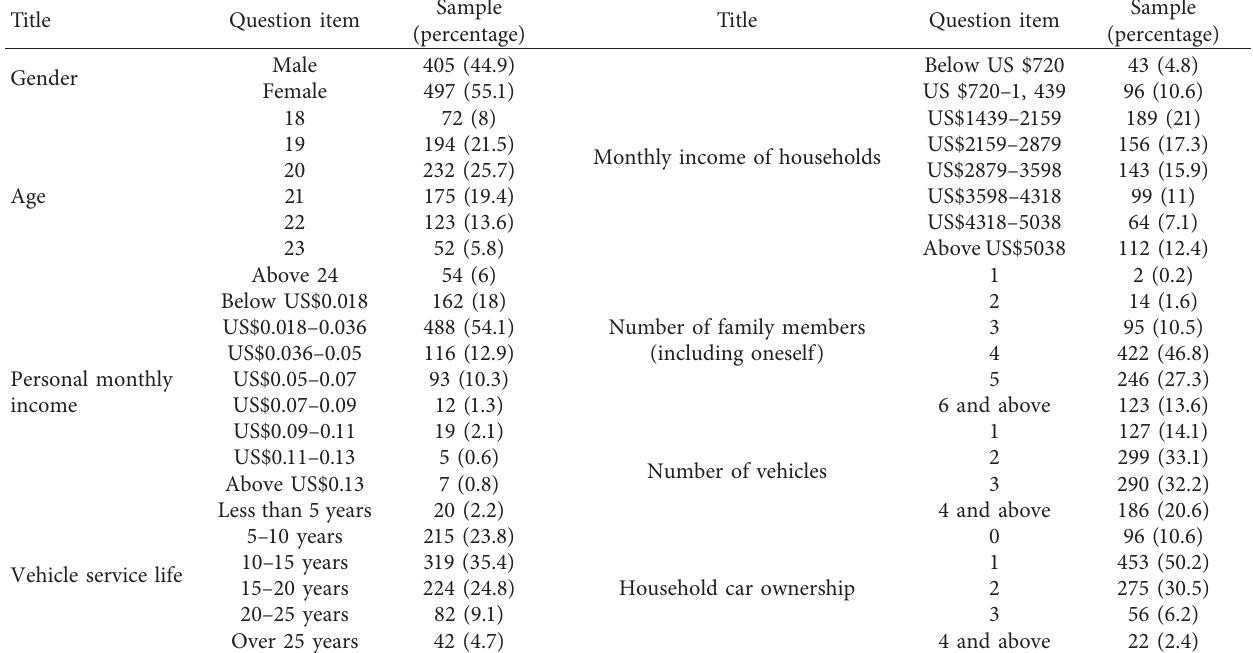
Table 4: Basic data